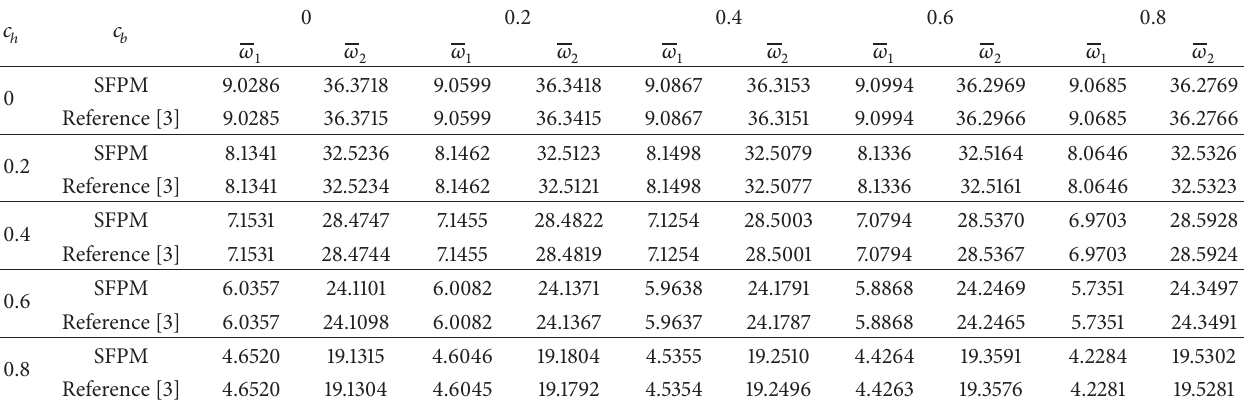
Table 8: Nondimensional transverse natural frequencies 𝜔 𝑖 for axially FG tapered beam; boundary condition: